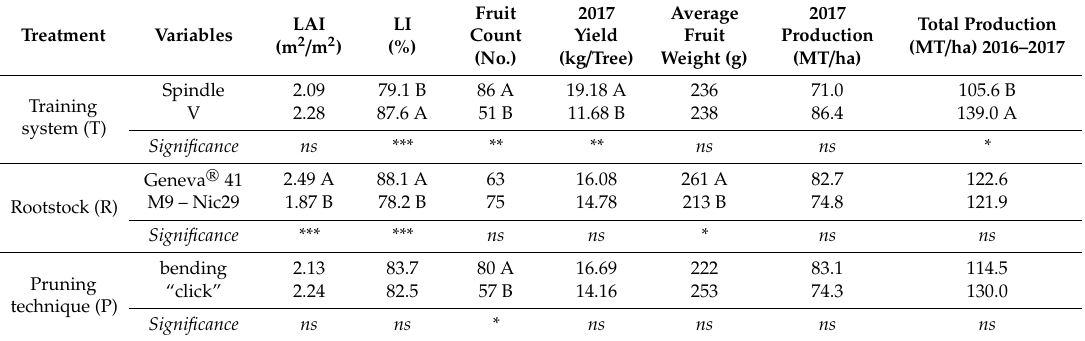
Table 2. The e ff ects of the training system, rootstock, and pruning technique on leaf area index (LAI) (m 2 / m 2 ), light interception (LI) (%), fruit count (number of fruit / tree), yield (kg / tree), average fruit weight (g), production (MT / ha) and total production (MT / ha, 2016 and 2017) for “WA38” trees grown in Wenatchee area in Washington State in